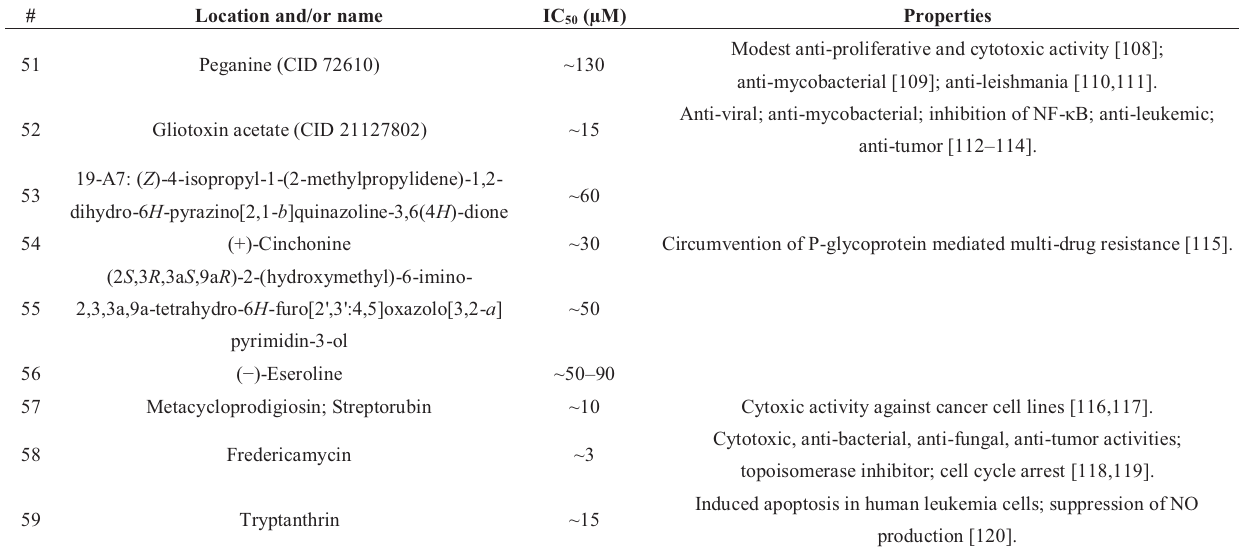
Table 6. Alkaloid compounds.